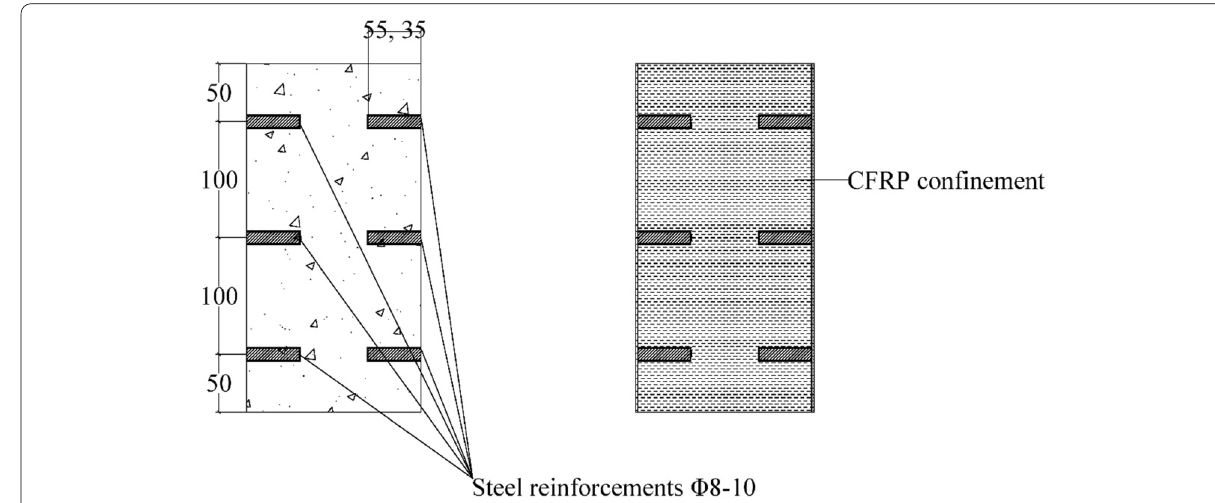
Fig. 2 Rebar arrangement and CFRP confinement schematics of specimen.